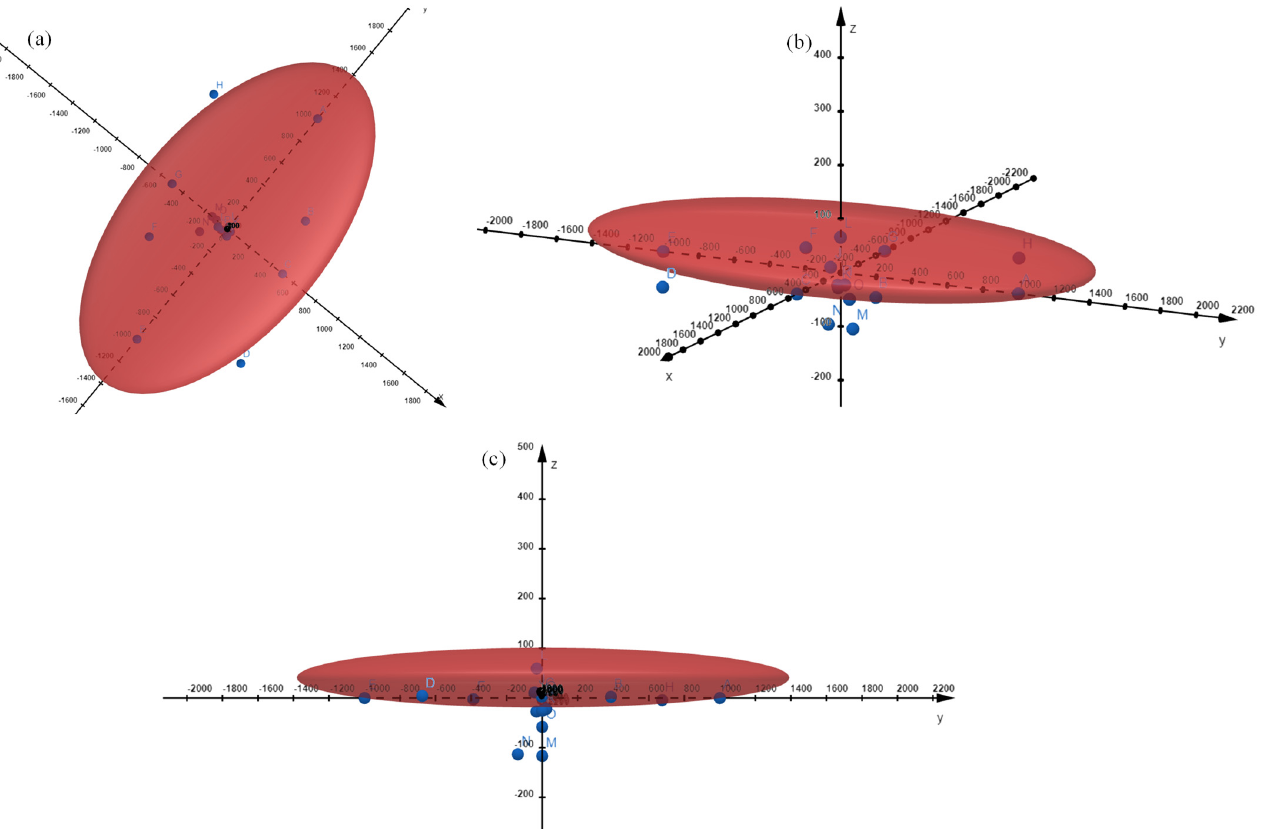
Figure 6. Result of 3D ellipsoid anisotropy viewed from: ( a ) top, ( b ) front, and ( c ) side.